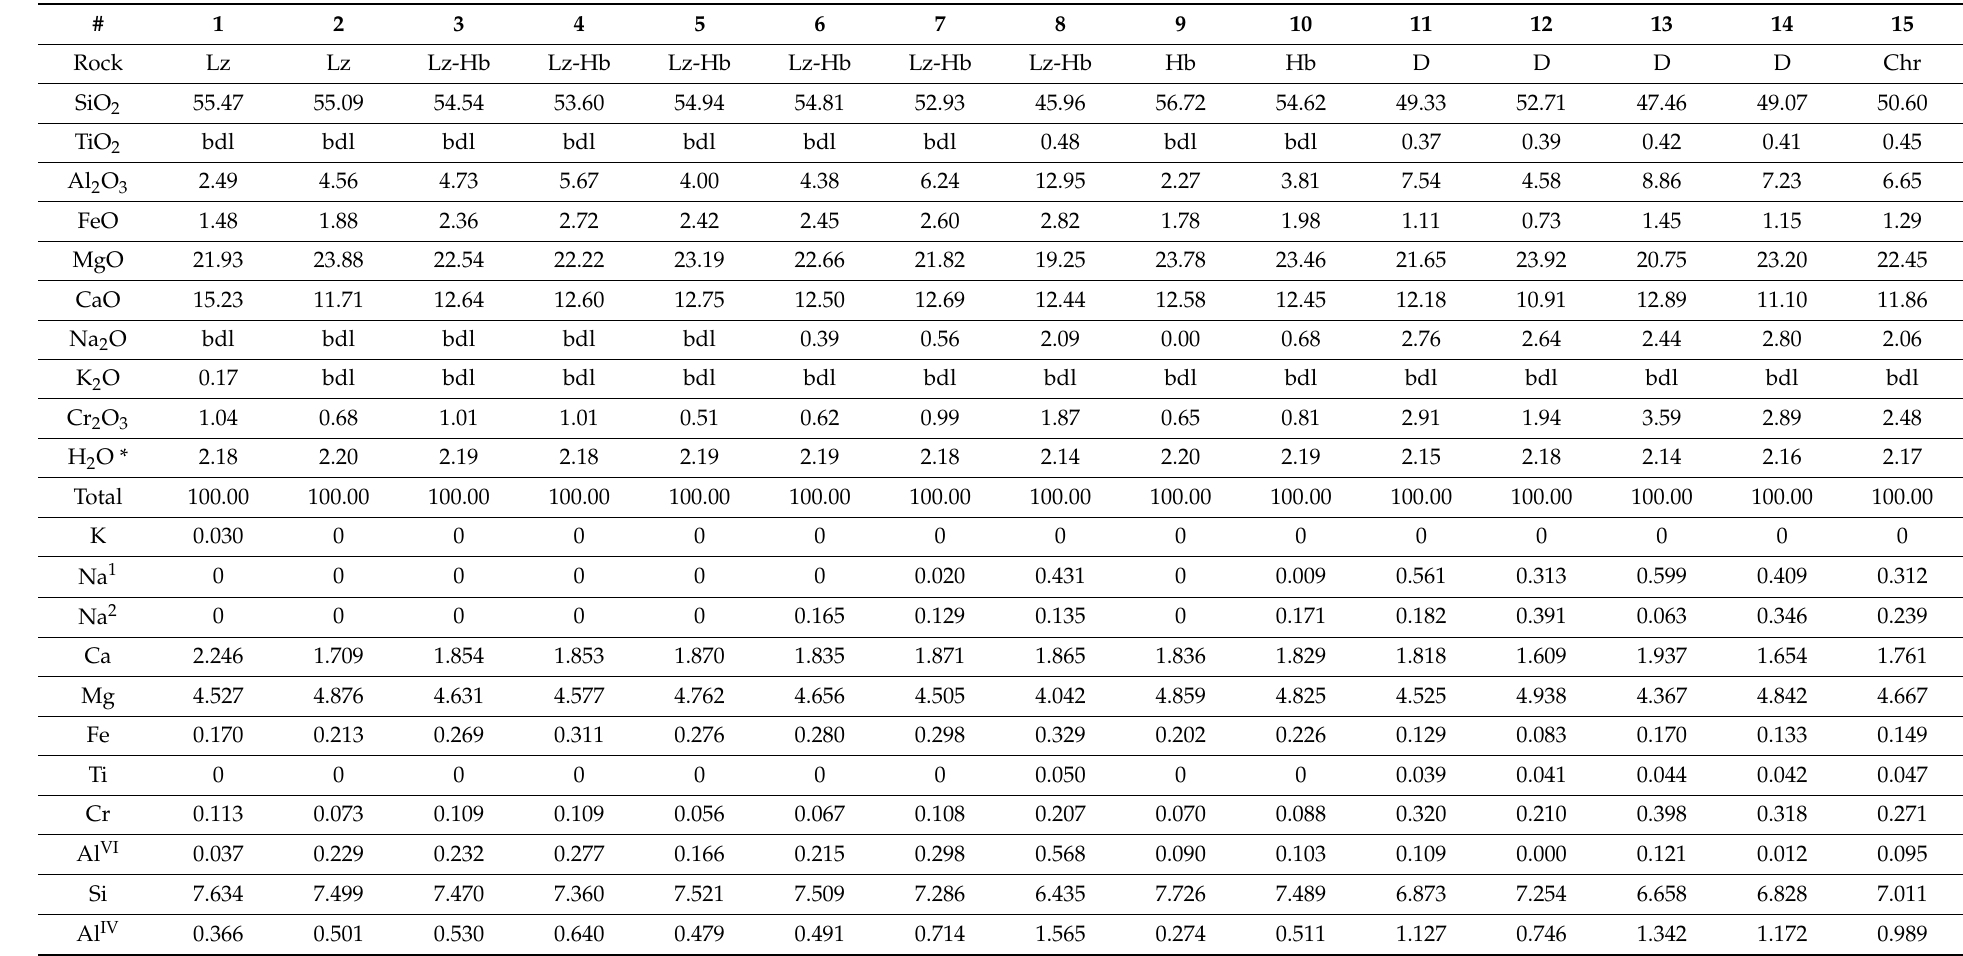
Table 5. Composition of amphibole grains in peridotite of Kempirsay massif